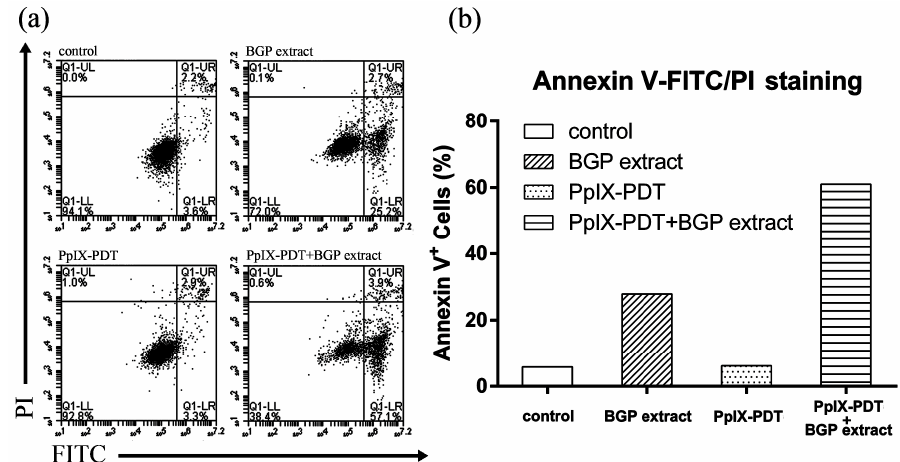
Figure 4. Annexin V-FITC/PI staining of A431 cells. ( a ) Cells were treated with or without Brazilian green propolis (BGP) extract in protoporphyrin IX-mediated photodynamic therapy (PpIX-PDT) and stained using Annexin V-FITC/PI staining assay before detection by a BD Accuri TM C6 flow cytometer. All groups were illuminated by laser; ( b ) The percentages of apoptotic cells.